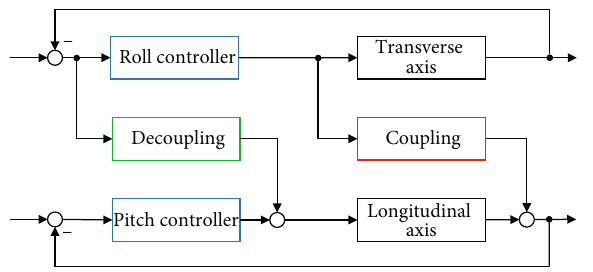
Figure 5: Decoupling structure of the lateral and longitudinal axes. After initiating a left or a right turn fl ight, the nose of the airframe is dropping. The controllers for stabilization are marked in blue, the physical coupling of the system in red, and the corresponding decoupling in